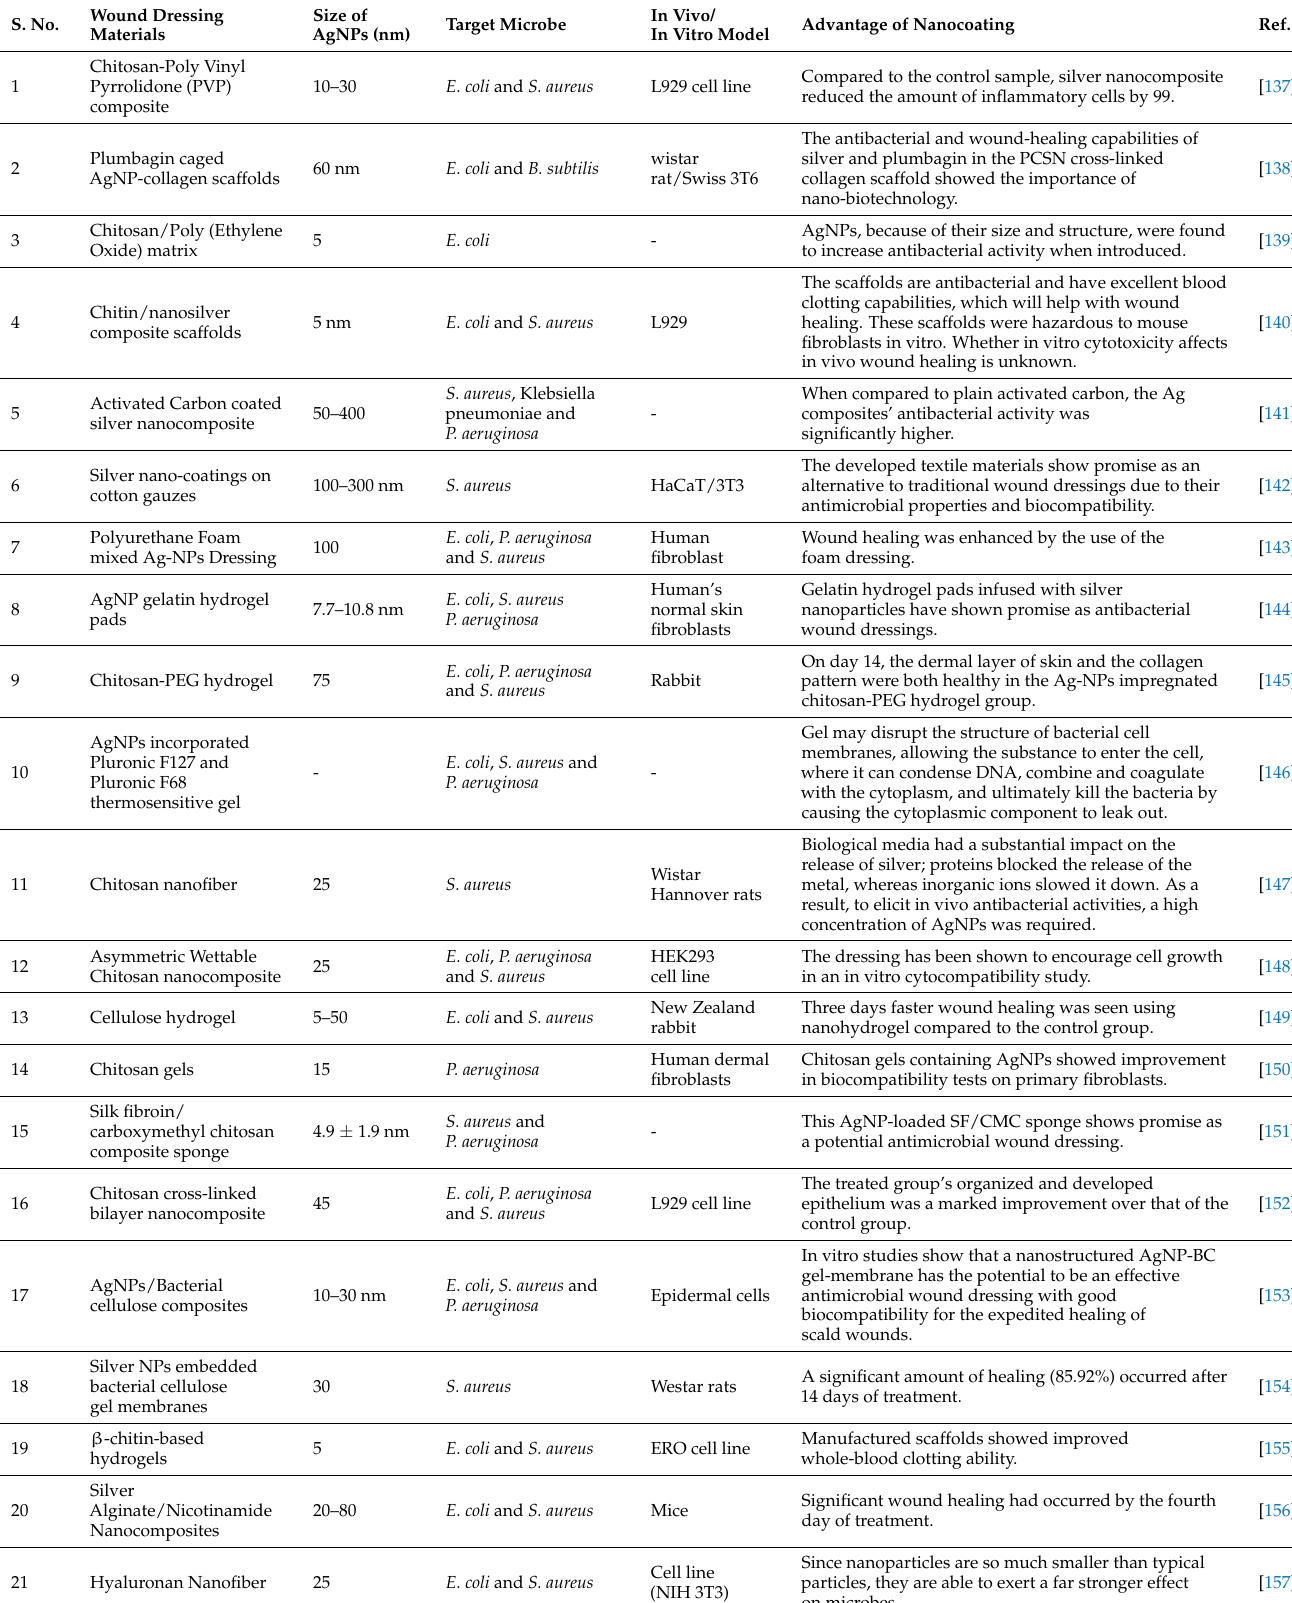
Table 3. A summary of available AgNP-based wound dressing products and their